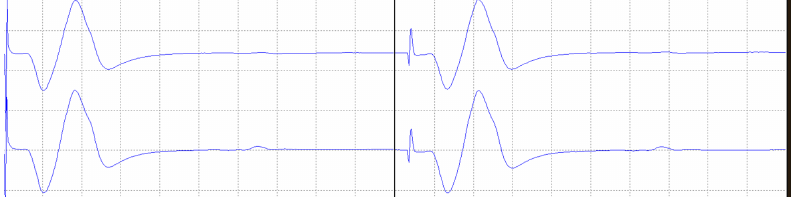
Figure 14. MEP of a healthy volunteer. Curves on the left originally obtained from the system. Curves on the right, obtained from the proposed system. Voltage scale is 2mV/div, time scale is 5ms/div.